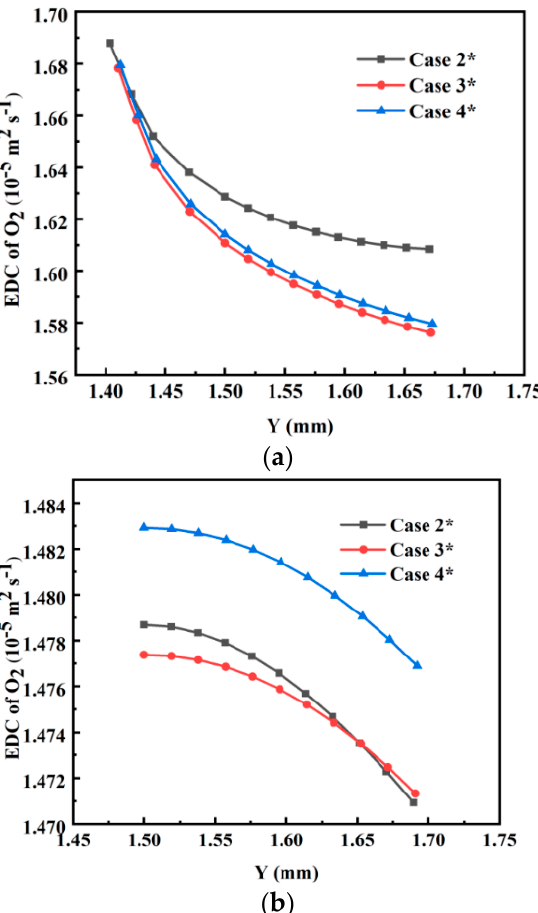
Figure 13. Distribution of effective diffusion coefficient (EDC) of oxygen in the GDL under different water contents in Case 2*, Case3* and Case 4*: ( a ) under the channel; ( b ) under the rib.